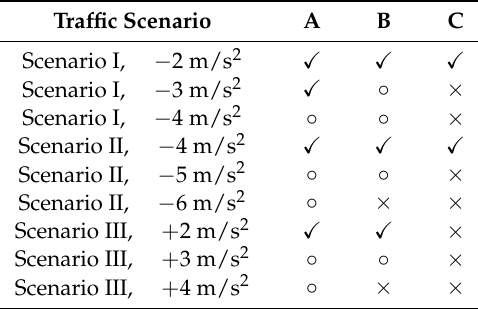
Figure 7. Simulation results for Scenario I. From top to bottom, the graphs of host vehicle V H are: 2-D trajectory, longitudinal velocity, longitudinal acceleration, lateral position, lateral velocity, lateral acceleration and the distance to the nearest front/rear vehicle. Table 4. Experimental Results of Different